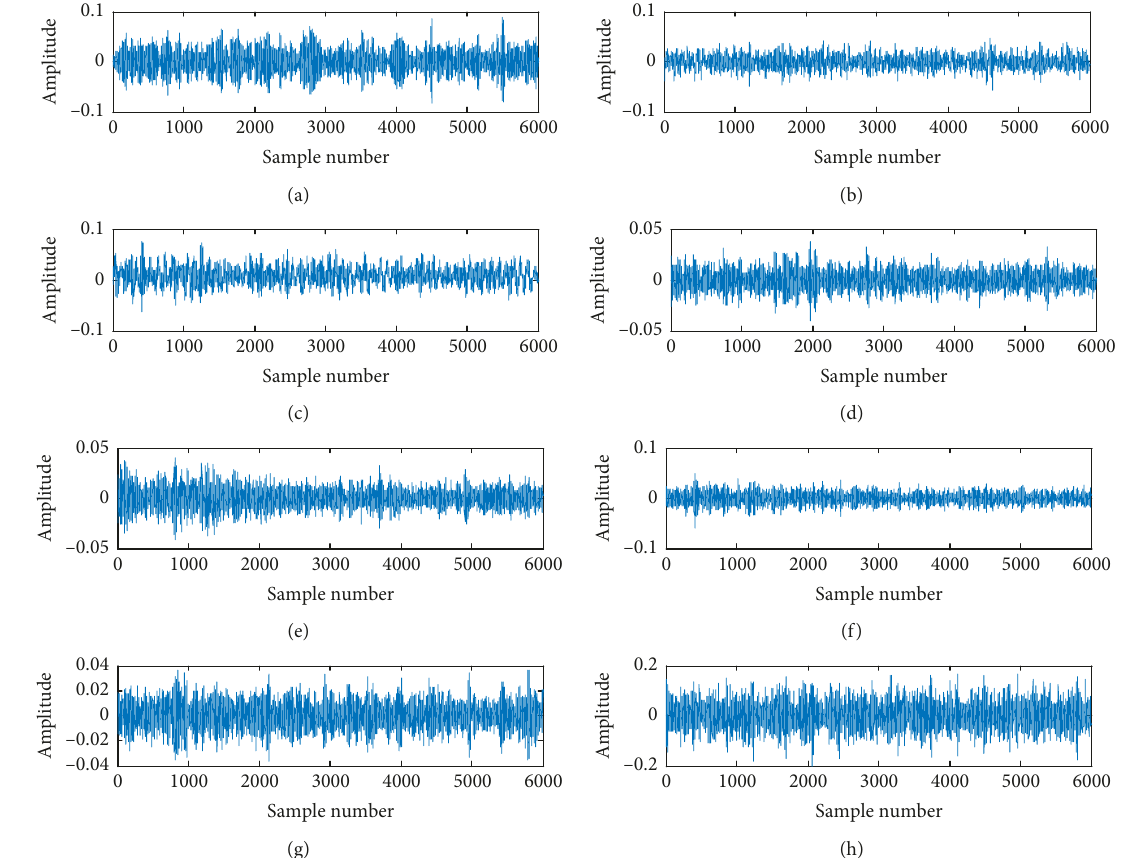
Figure 8: Multiresolution DMD modes of roller bearing’s ball fault signal